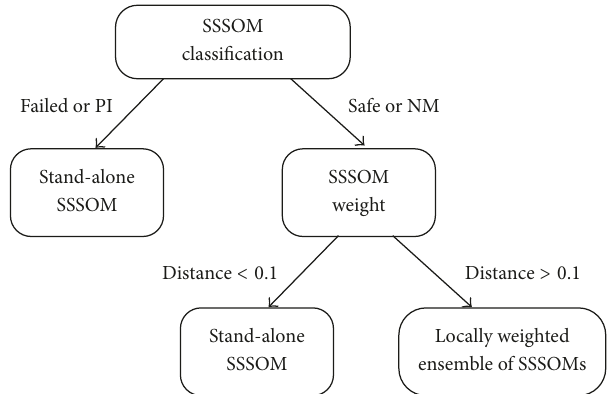
Figure 4: Decision tree based classifier.